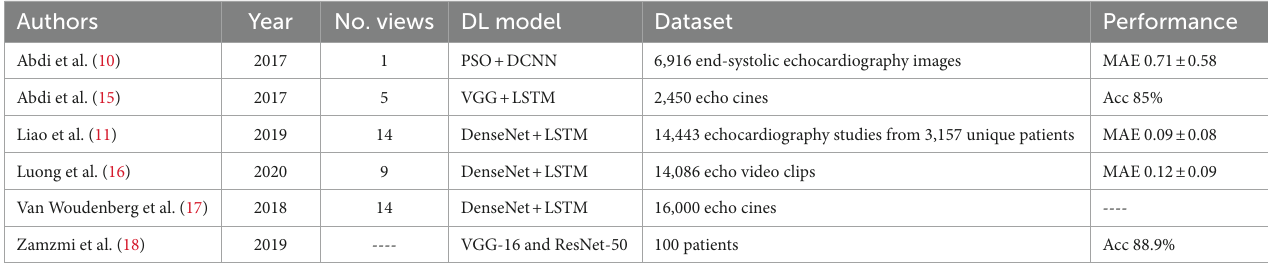
TABLE 1 Deep learning based studies for quality